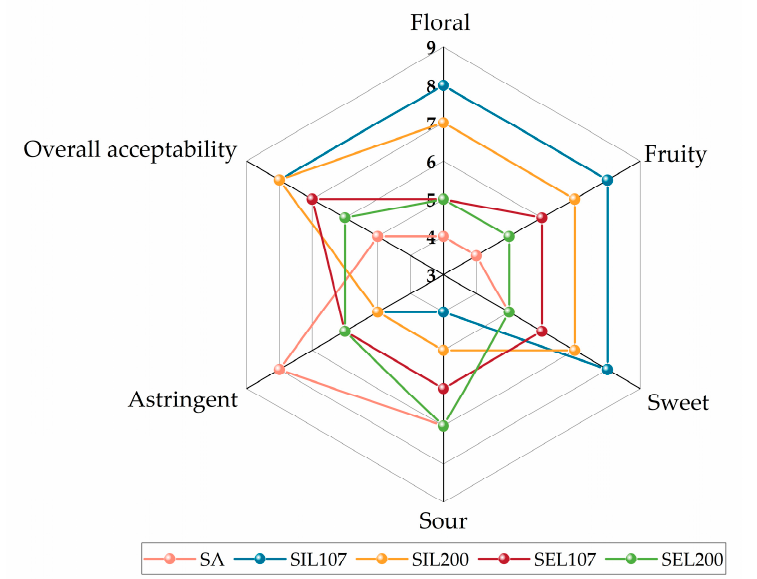
Figure 6. Sensory profiles obtained for ciders fermented with a single culture and mixed cultures.